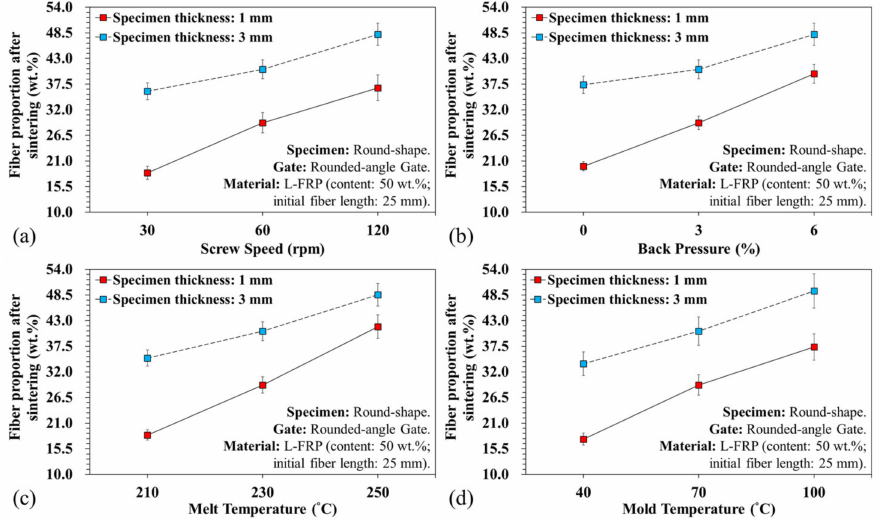
Figure 9. Variations of the fiber proportions under different specimen thicknesses and plasticization parameters: ( a ) variations of screw speed, ( b ) variations of back pressure, ( c ) variations of melt temperature, and ( d ) variations of mold